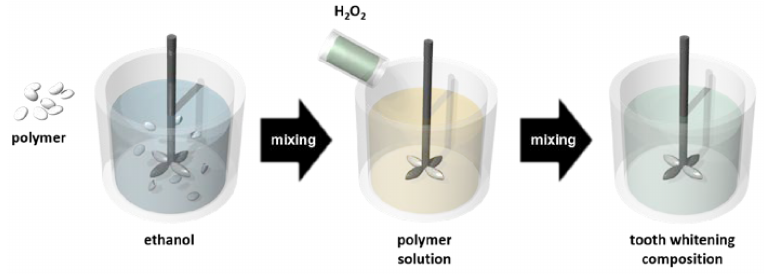
Figure 1. Illustration of manufacturing process of polymeric tooth whitening